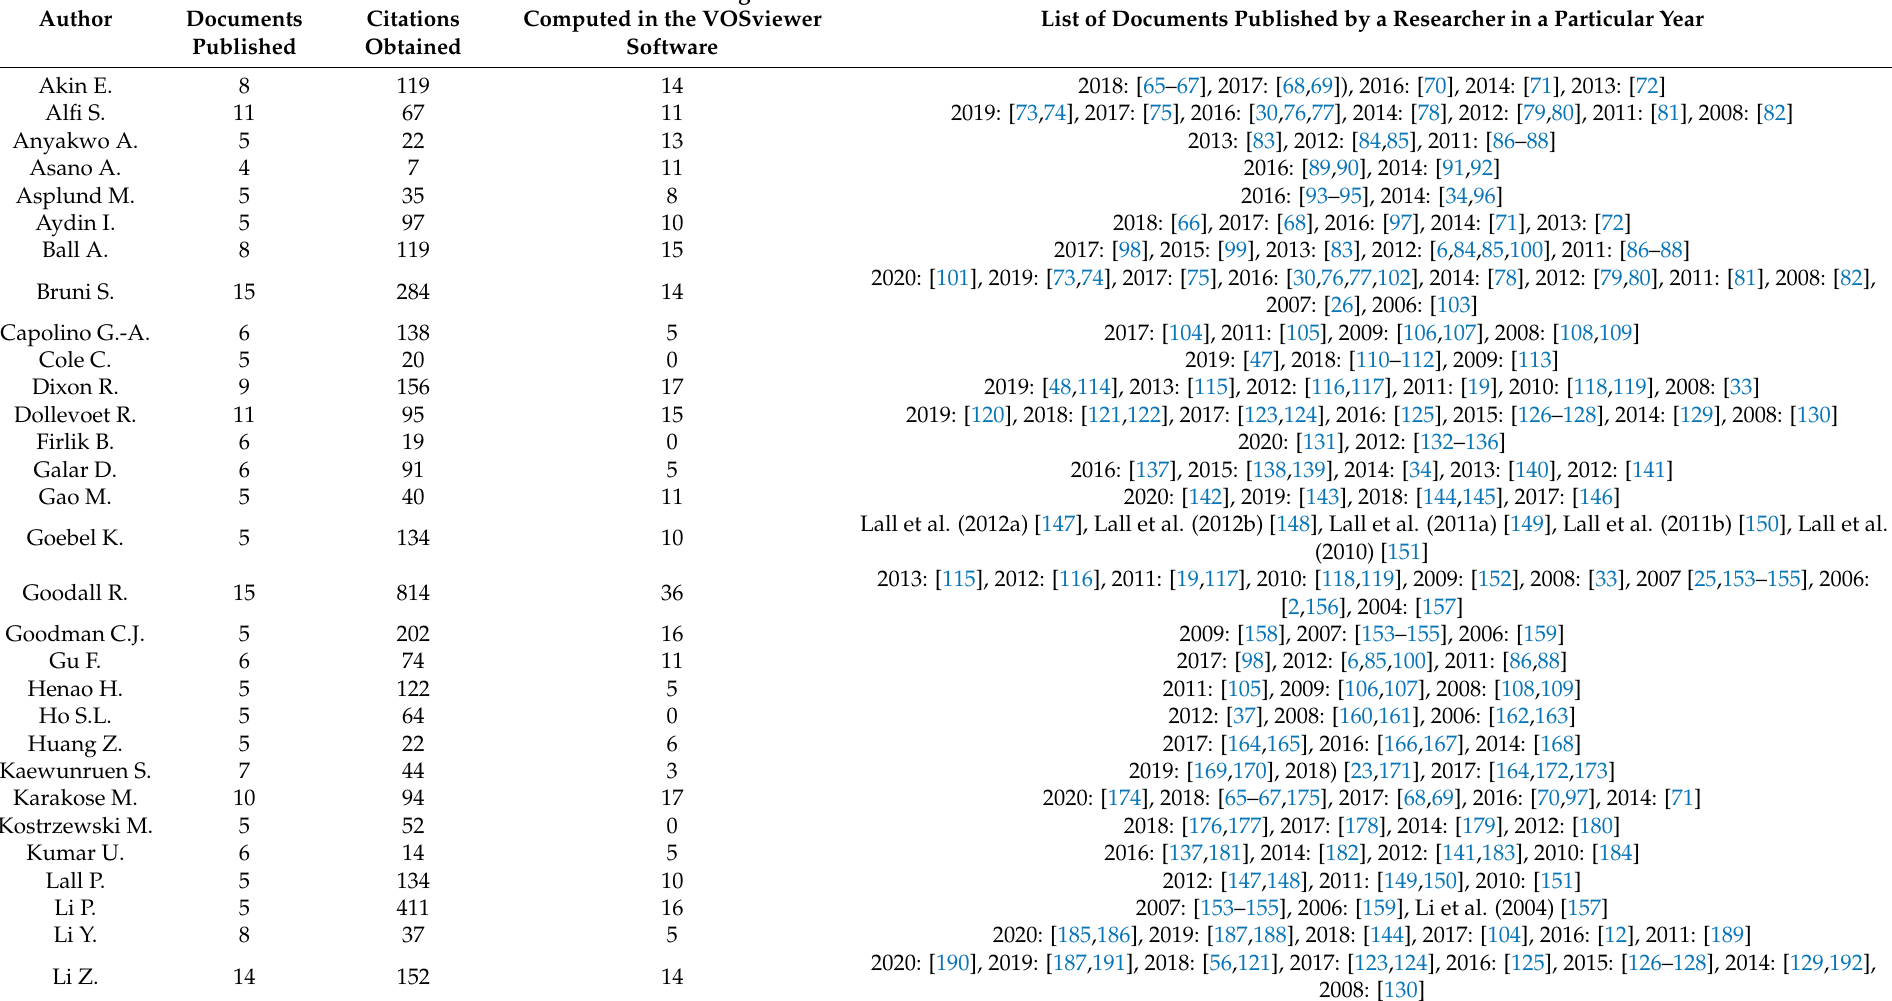
Table 2. Cooperation in publication and citation of the researchers cited in the case of the internal keywords “condition monitoring”, obtained using VOSviewer software (version